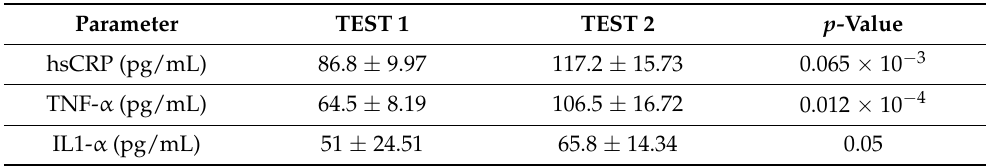
Table 3. Comparative analyses of biochemical inflammatory markers, after periodontal disease induction. Parameter TEST 1 TEST 2 p- Value hsCRP